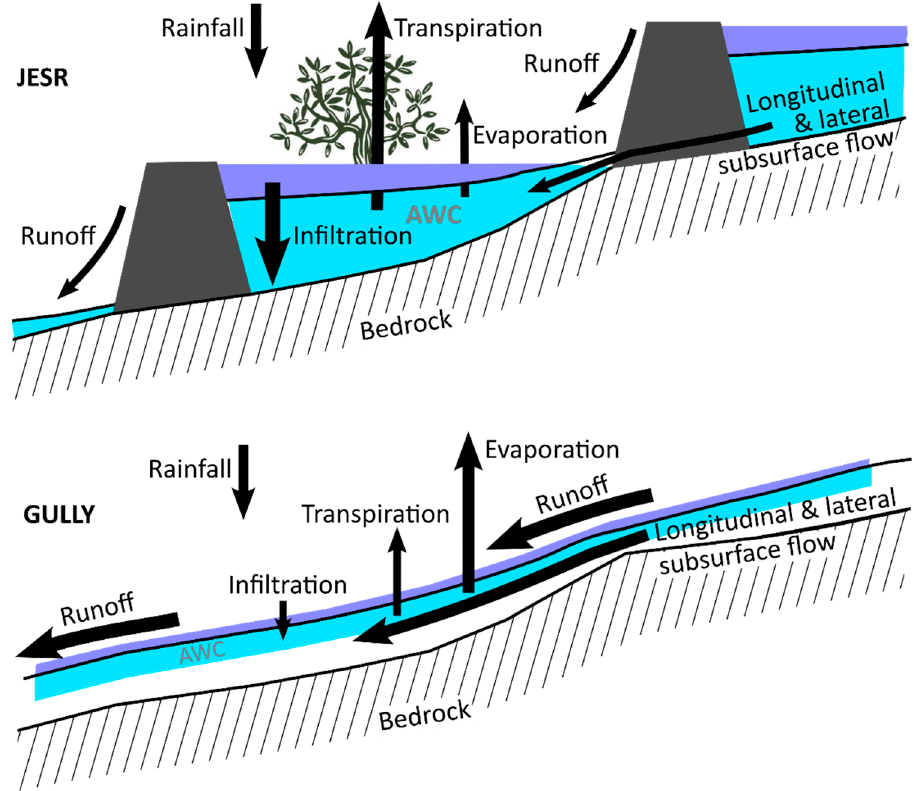
Figure 11. Schematic water balance for the Jesr and the gully. Turquoise: infiltrated water and subsurface flow and blue: surface runoff.